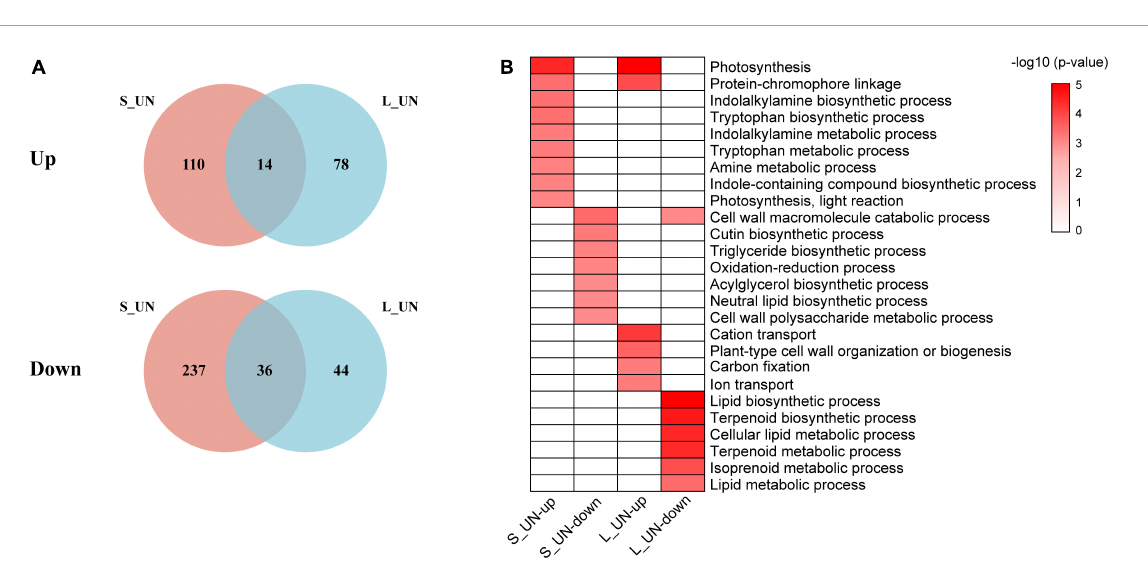
FIGURE3 Venn diagram and functional analysis of DEGs of different time periods of NH 4 + deficiency. (A) Venn diagram of the number of upregulated and downregulated DEGs between short-term NH 4 + deficiency and long-term NH 4 + deficiency. (B) Significantly enriched GO terms (biological process) of specific DEGs between different NH 4 + deficiency durations (Bonferroni’s test, p <